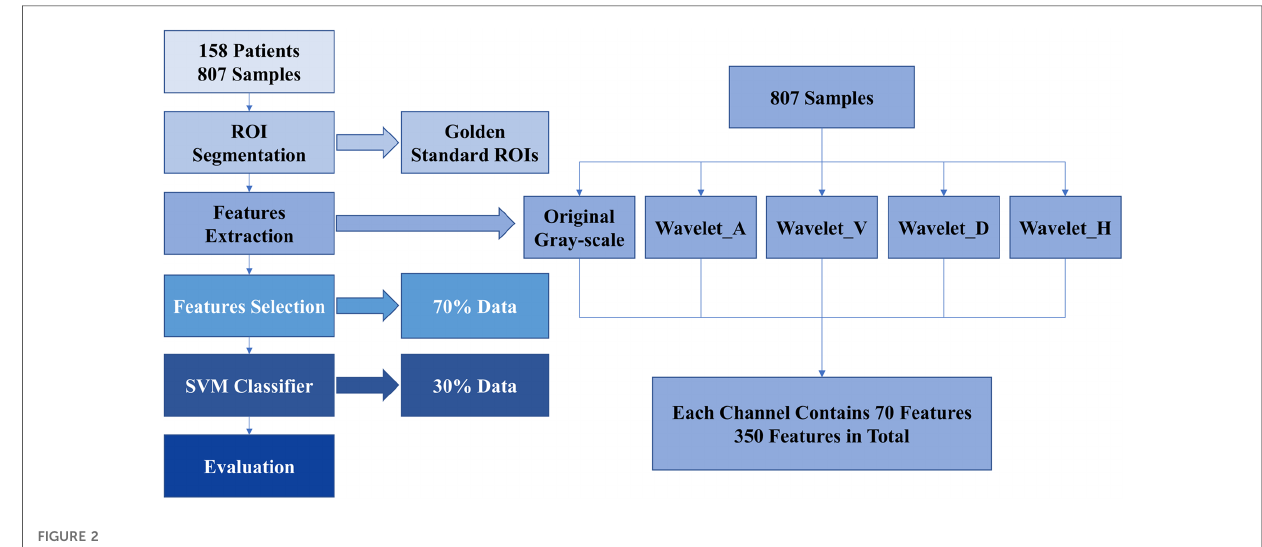
FIGURE 2 Overview of our ultrasound radiomics diagnostic system.